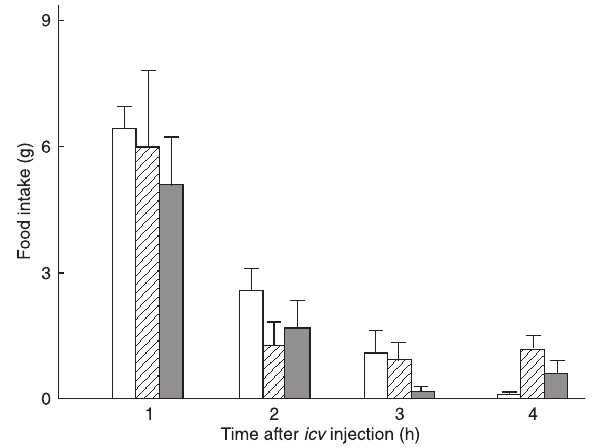
Figure 2. Effects of icv injection of SR59230A [β 3 -adrenergic re- ceptor antagonist at doses of 10 (gray bars) and 50 nmol (striped bars)] on food intake of 24-h fasted rats. Vehicle (saline) are open bars. Data are reported as means ± SEM. Table 2. Effects of icv injection of BRL37344 (a β 3 -adrenergic agonist) or SR59230A (a β3-adrenergic antagonist) on the fre- quency of risk assessment behavior in 24-h fasted